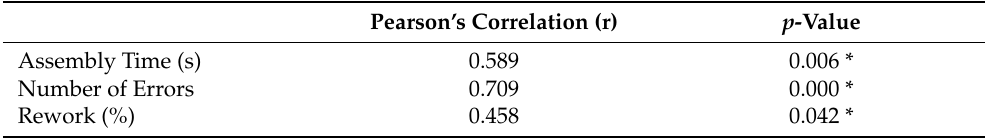
Table 11. Pearson’s correlation—search efficiency (average convex hull coverage) by pipefitter assembly performance (assembly time (s), number of errors, rework (%)).